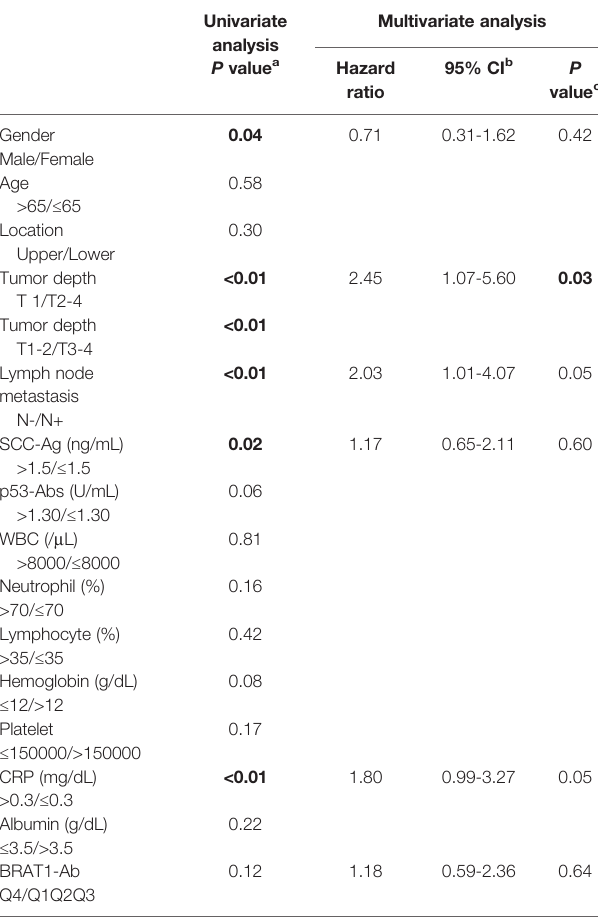
TABLE 4 | Comparison of serum BRAT1-Ab levels between HDs and patients with ESCC, GC or CRC examined by AlphaLISA. Patient group